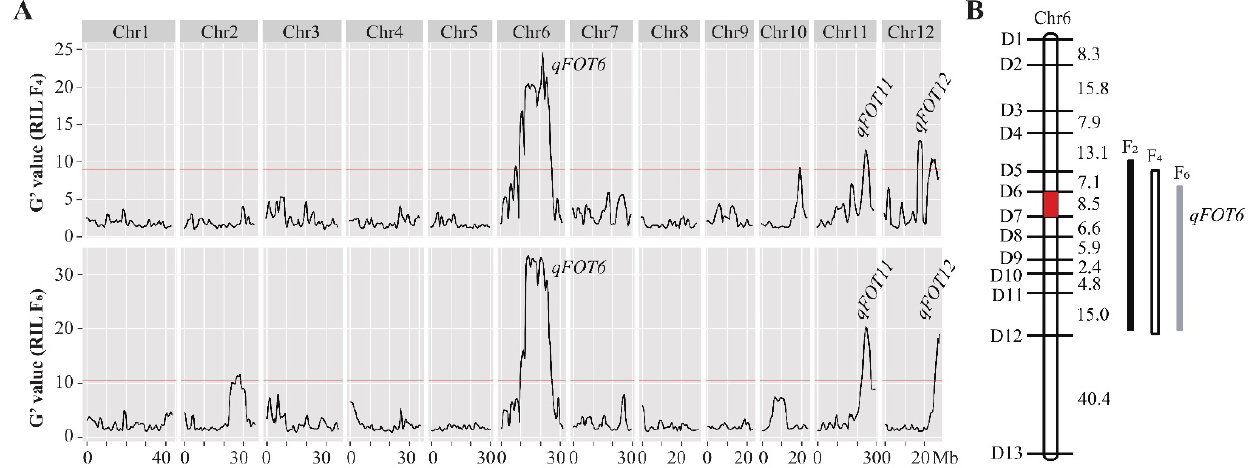
Figure 3. The multi-year verification of qFOT6 . ( A ) The QTL mapping of FOT in G23 was performed using the QTLseqr method in the F 4 (top) and F 6 (bottom) RIL populations. Plots were produced using the plotQTLStats function with a l Mb sliding window. Y -axis represents G’ value. The red lines represent the threshold line with a confidence level of 0.99. X -axis represents the chromosome interval. ( B ) Genetic linkage map and the location of qFOT6 detected in different populations. The names and positions of markers in centimorgans (cM) are given on the left and right sides sepa- rately. Table 1. Identification of qFOT6 using composite interval mapping in F 2 .